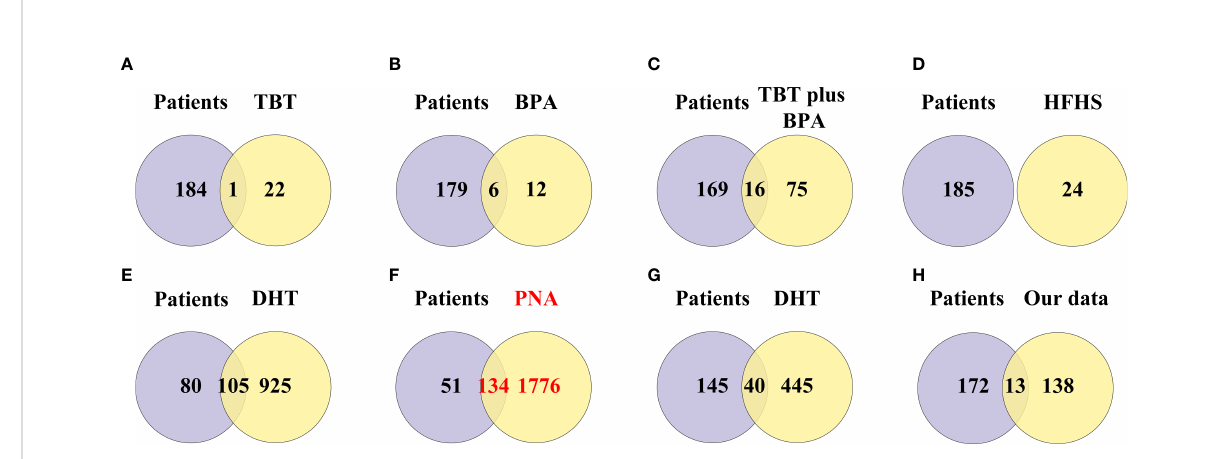
FIGURE 6 Venn diagram showing the intersection of pathway enrichment analyzes between PCOS animal models and patients. (A) GO and KEGG terms enriched in the TBT-induced PCOS rat model. (B) GO and KEGG terms enriched in the BPA-induced PCOS rat model. (C) GO and KEGG terms enriched in the TBT plus BPA-induced PCOS rat model. (D) GO and KEGG terms enriched in the HFHS-induced PCOS rat model. (E) GO and KEGG terms enriched in the DHT-induced PCOS rat model. (F) GO and KEGG terms enriched in the PNA PCOS mouse model. (G) GO and KEGG terms enriched in the DHT- induced PCOS mouse model. (H) GO and KEGG terms enriched in the DHEA plus HFD-induced PCOS mouse mod.